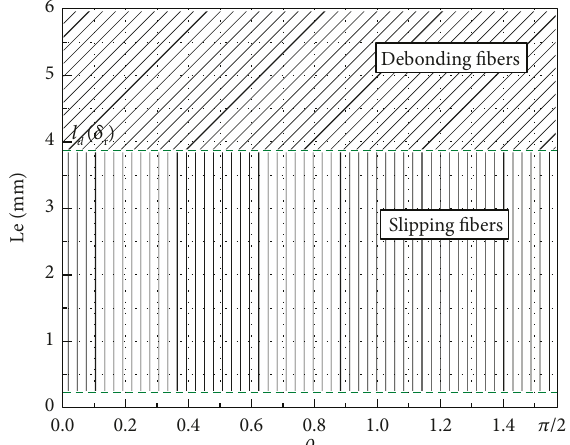
Figure 4: Fiber states without fiber rupture analysis.